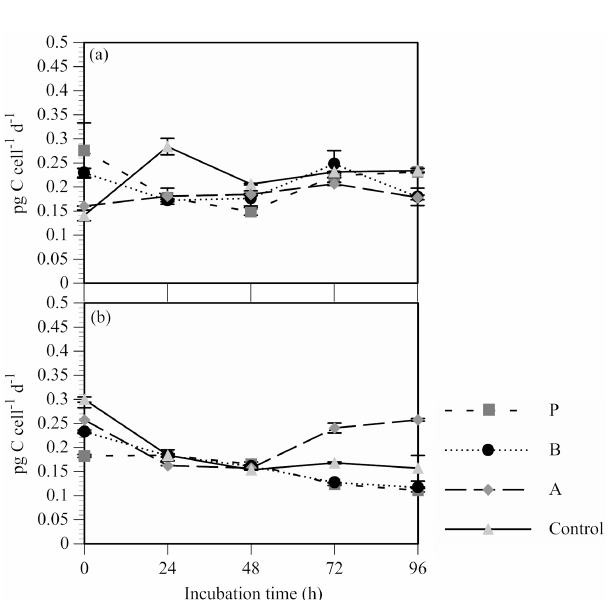
Figure 2. Bacterial cell numbers (mean ± SE, n = 3) in response to seawater acidified with 0.1 M HCl (A), bubbled with CO 2 –air gas mixture (B) and CO 2 –air gas mixture introduced through gas- permeable silicon tubing (P). (a) Trial 1. (b) Trial 2.